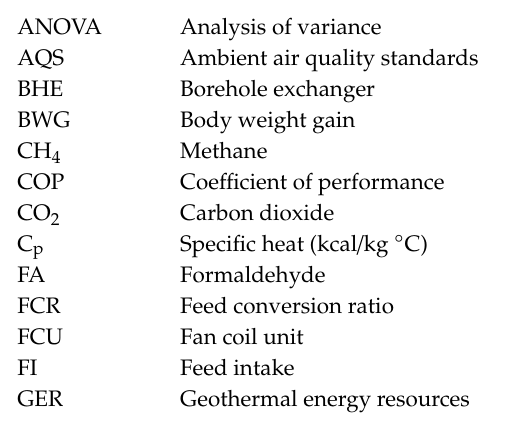
Figure S1: A geothermal heat pump system, Figure S2: NR-TH set for temperature and humidity detection. Sensors for determination of NH 3 and H 2 S emission, Figure S3: Smart sensor air quality meter, Table S1: Specifications of geothermal heat pump, Table S2: Specifications of exhaust fans in pig